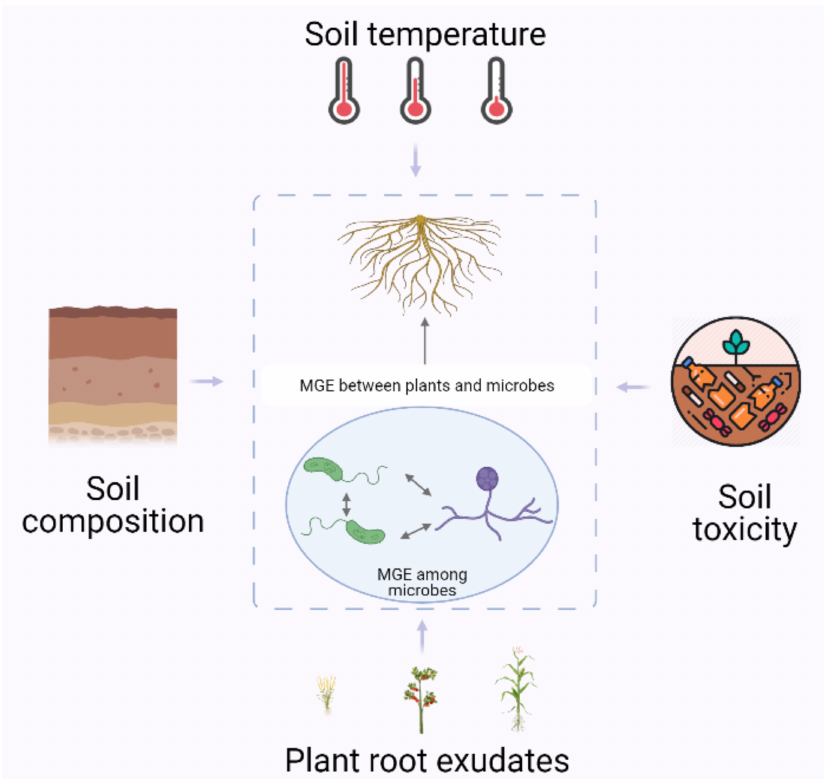
Figure 1. Mobile genetic elements (MGEs), including DNA and RNA, are extensively transferred among bacteria, fungi and plants in the rhizosphere. In the natural environment, factors including soil temperature, composition, toxicity and root exudates from plants influence MGE transfers in the rhizosphere. This figure was generated using